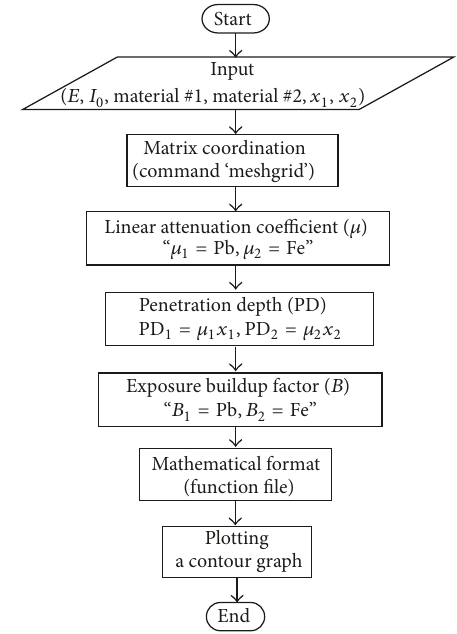
Figure 5: Overview flowchart of plotting a contour graph. Table 1: Calculated mass attenuation coefficient (𝜇/𝜌) and exposure buildup factor (𝐵) at 𝐸 input = 1.3325 MeV. PD is calculated from (6).